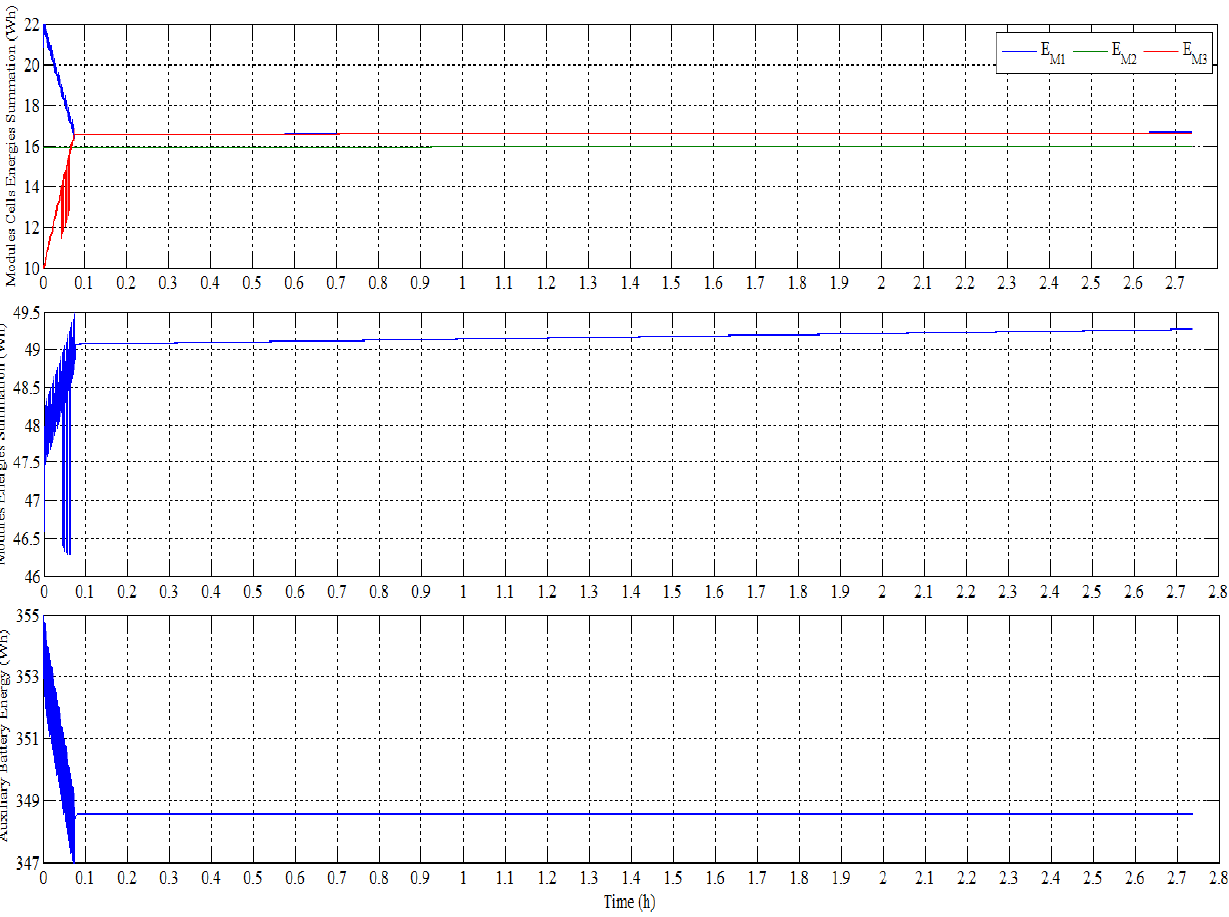
Figure 13. Simulation No. 2 (proposed SSCs and BC) results: modules energies, energies summation and the auxiliary battery (AB)